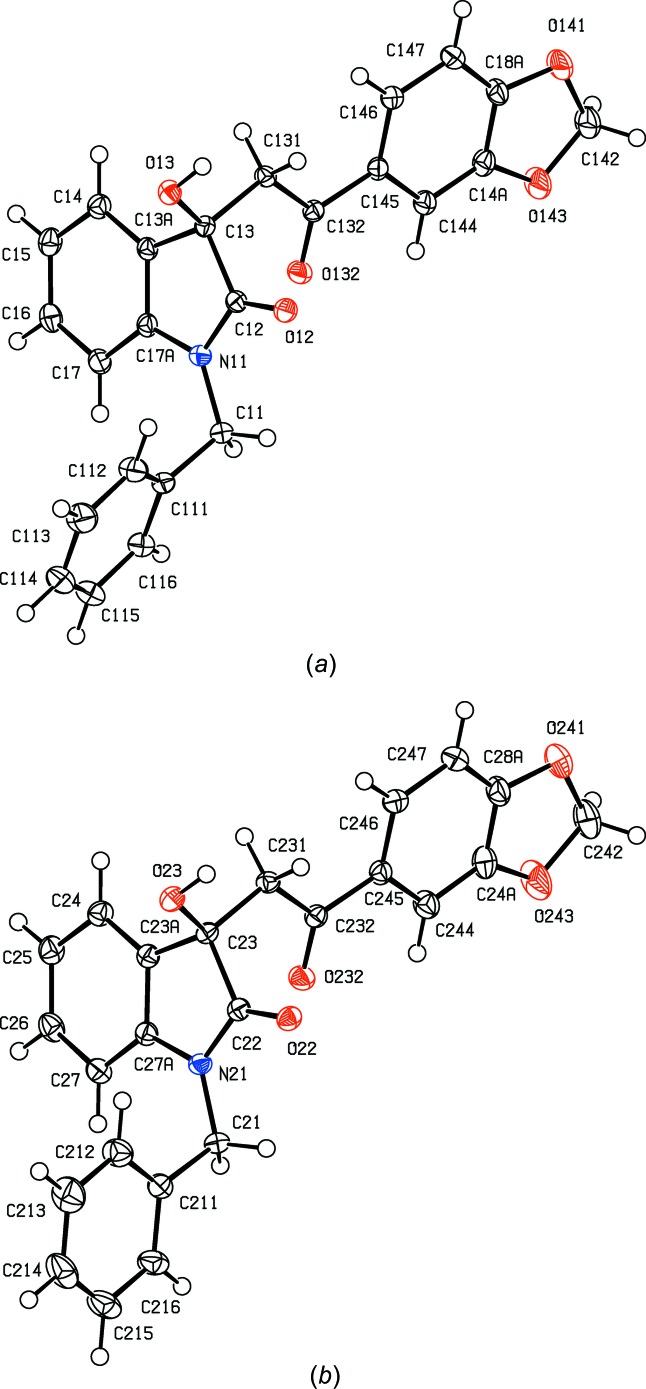
The R enanti­omers of the two independent mol­ecules of com­pound (If), showing the atom-labelling schemes for (a) mol­ecule 1 and (b) mol­ecule 2. Displacement ellipsoids are drawn at the 30% probability level.